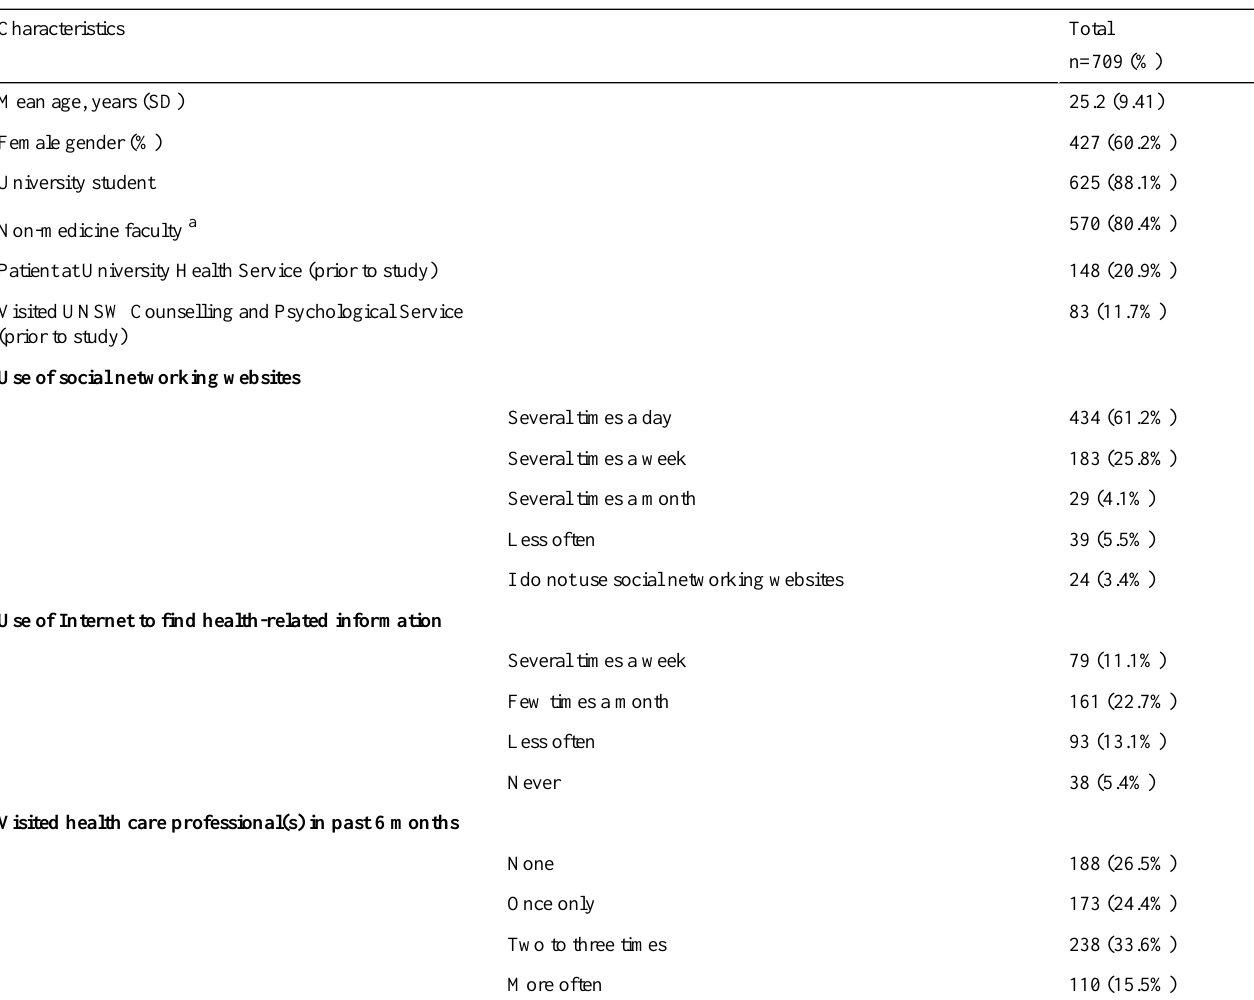
Table 1. Baseline characteristics of study participants who completed both pre-study and post-study